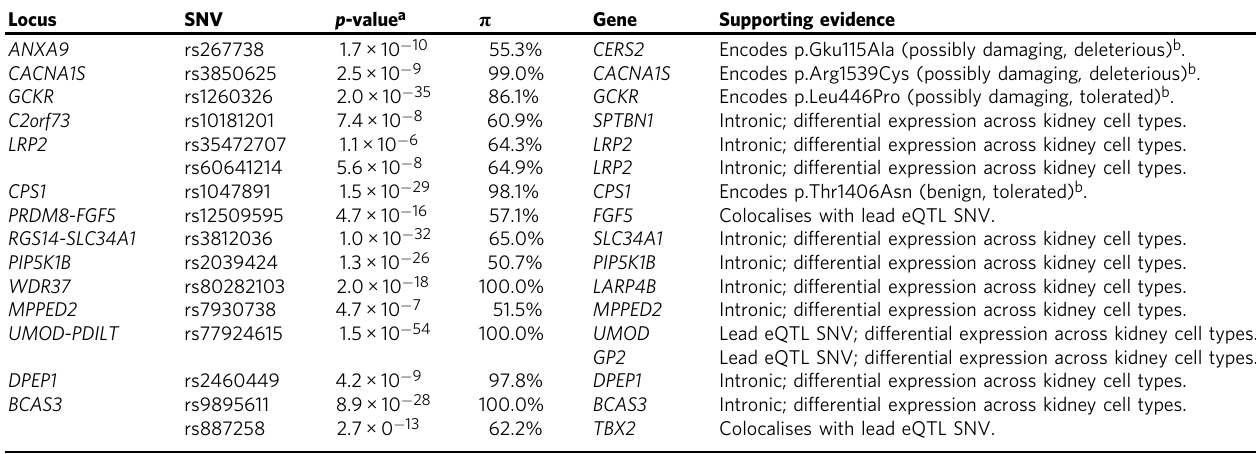
Table 2 High con fi dence SNVs driving eGFR associations and putative causal genes through which their effects on kidney function are mediated Locus